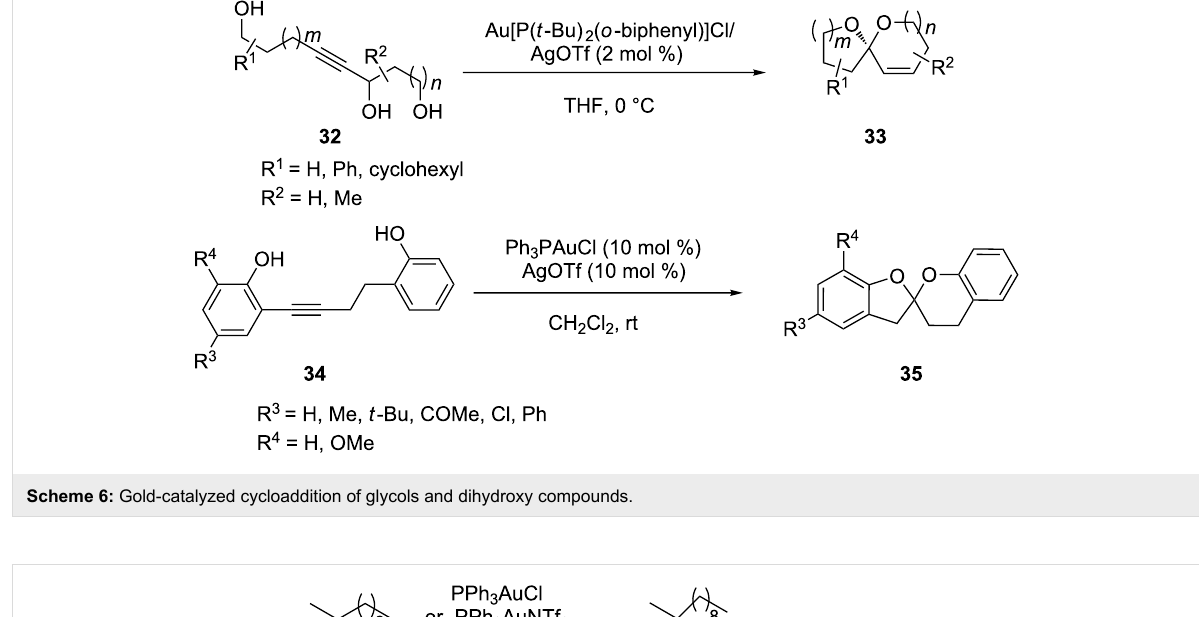
Scheme 6: Gold-catalyzed cycloaddition of glycols and dihydroxy compounds.